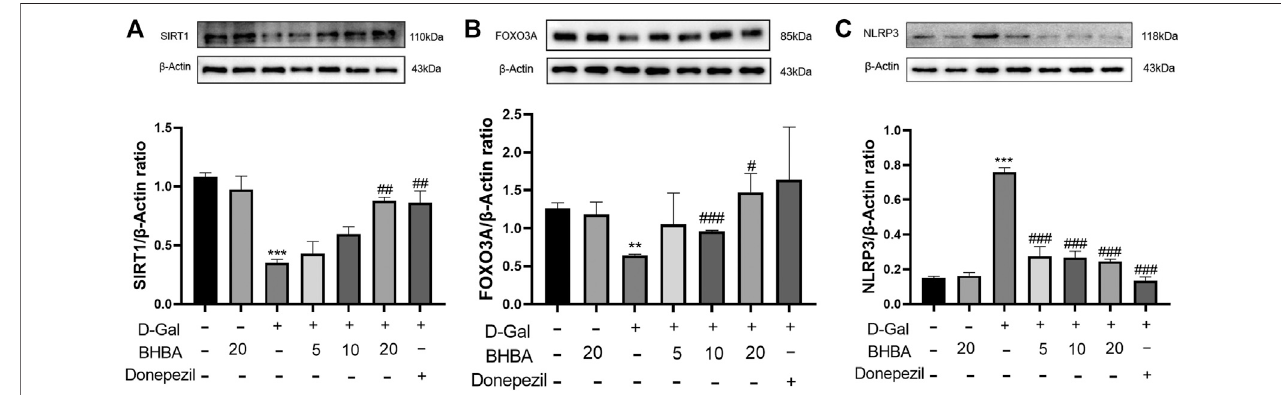
FIGURE 6 | Effects of BHBA on the expression of SIRT1, FOXO3A, and NLRP3 in D-gal-induced HT22 cells. (A) Protein expression of SIRT1. (B) Protein expression of FOXO3A. (C) Protein expression of NLRP3. D-gal: 200 mM; BHBA: 5, 10, and 20 mM, respectively; donepezil: 2 μ M, n (cid:1) 3. Compared with the control group, * p < 0.05,** p < 0.01, *** p < 0.001; compared with the D-gal group, # p < 0.05, ## p < 0.01, ### p <